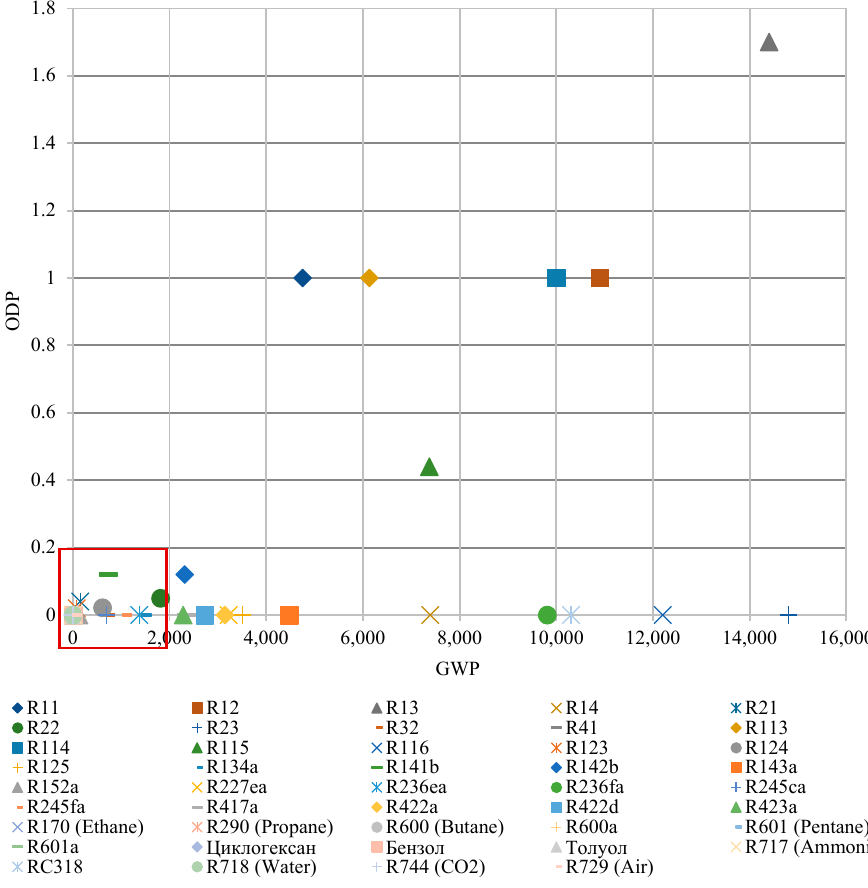
Figure 2. Environmental characteristics of working fluids.